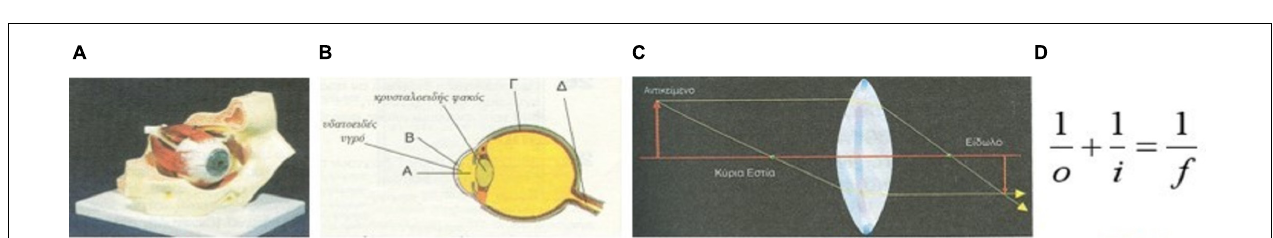
FIGURE 5 | (A–D) Conceptual completions of each inscription type regarding energy transfer.